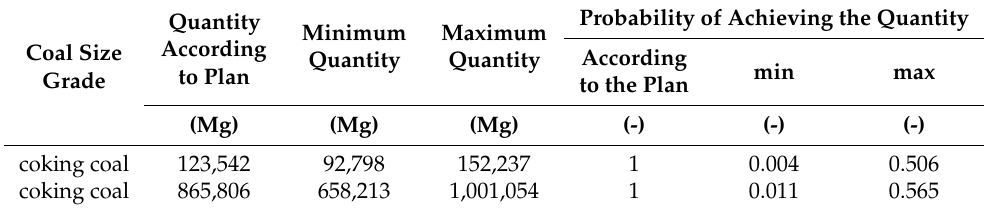
Table A12. A summary of the volumes of sales of the individual coal grades with the probability of their achievement at σ yprog for mine “C”.